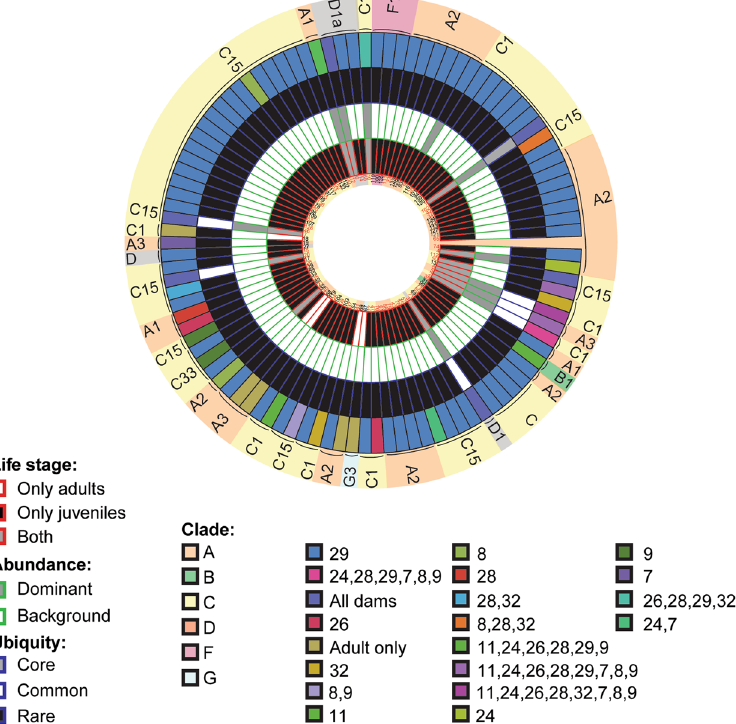
Figure 3. Circular trait plots of 101 Symbiodinium ITS-2 OTUs retrieved from Montipora digitata eggs and adults. Concentric circles from innermost to the outermost position represent OTUs present: (1) life-stage, (2) normalized abundance (principal: > 0.01%, background < 0.01%), (3) ubiquity (core: > 75% of samples, common: 25–75%, rare: < 25%), and (4) dam identity. Semi-transparent backgrounds represent clade designations of individual OTUs. Red text indicates OTUs that were found in three or more eggs or adults. See Supplementary Table S8 for full taxonomic